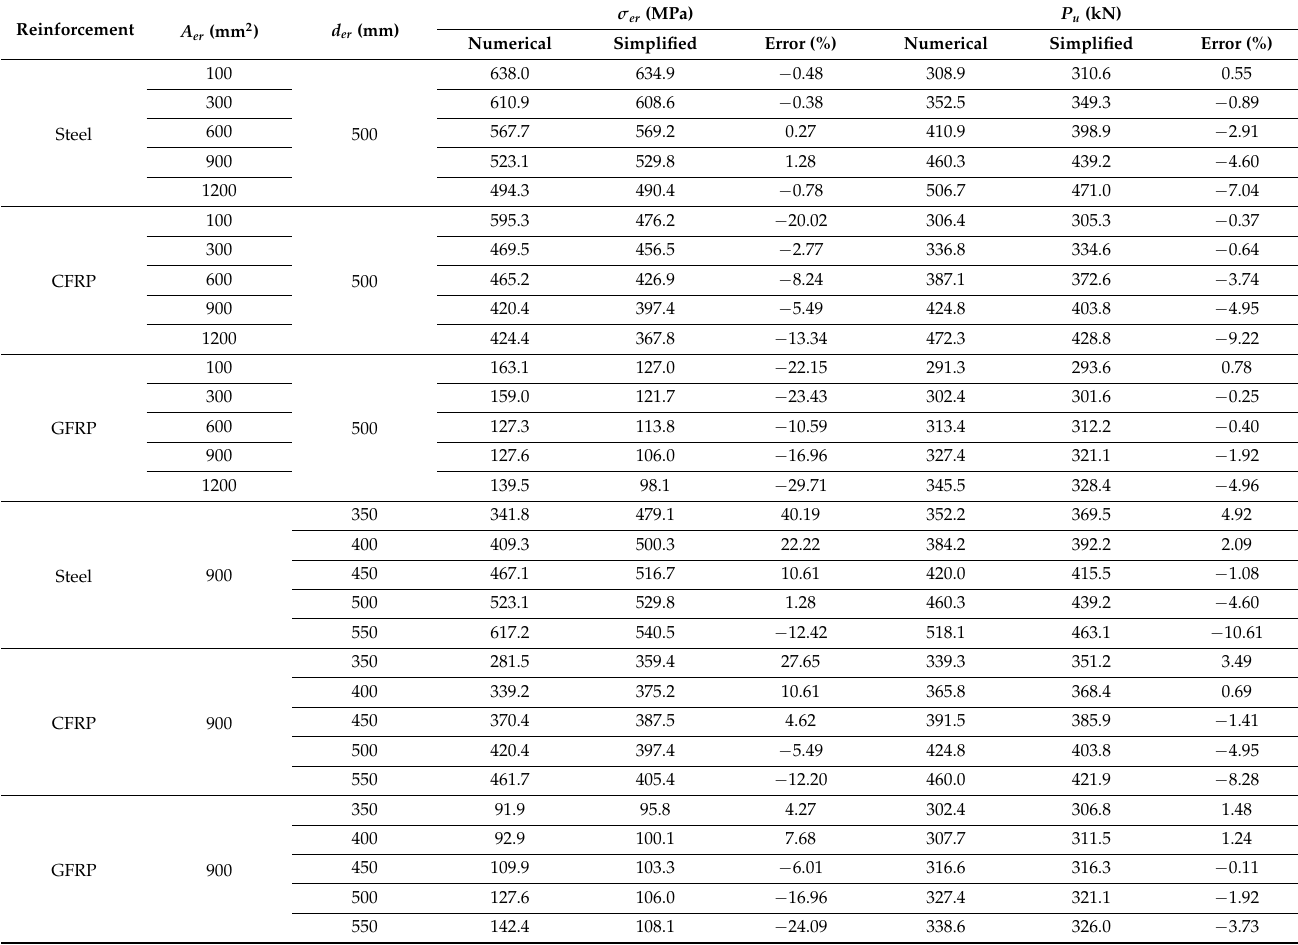
Table 1. Comparison of ultimate stress in external reinforcement and ultimate load obtained from simplified and numerical